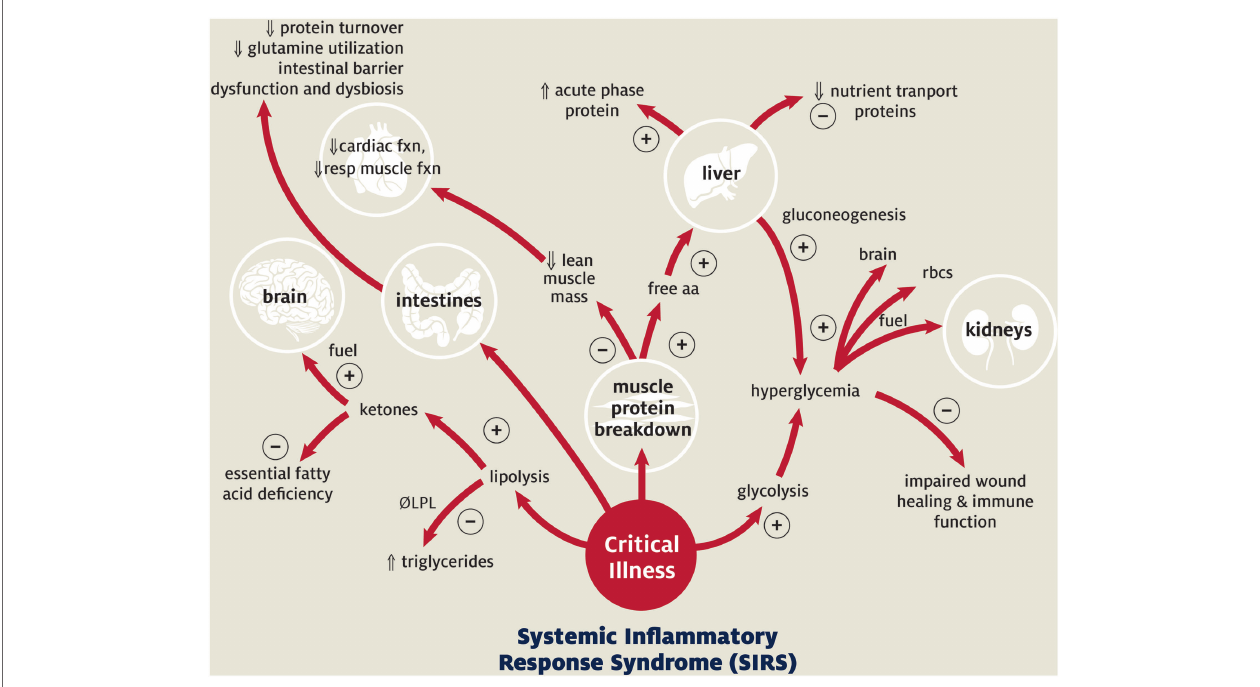
FiGURe 1 | Metabolic response to pediatric critical illness . + Acute adaptive response; − maladaptive consequence;  increased;  decreased. Abbreviations: LPL, lipoprotein lipase; aa, amino acids; resp, respiratory; rbc’s, red blood cells. Adapted with permission from Graciano and Turner (25). Copyright from the Society of Critical Care